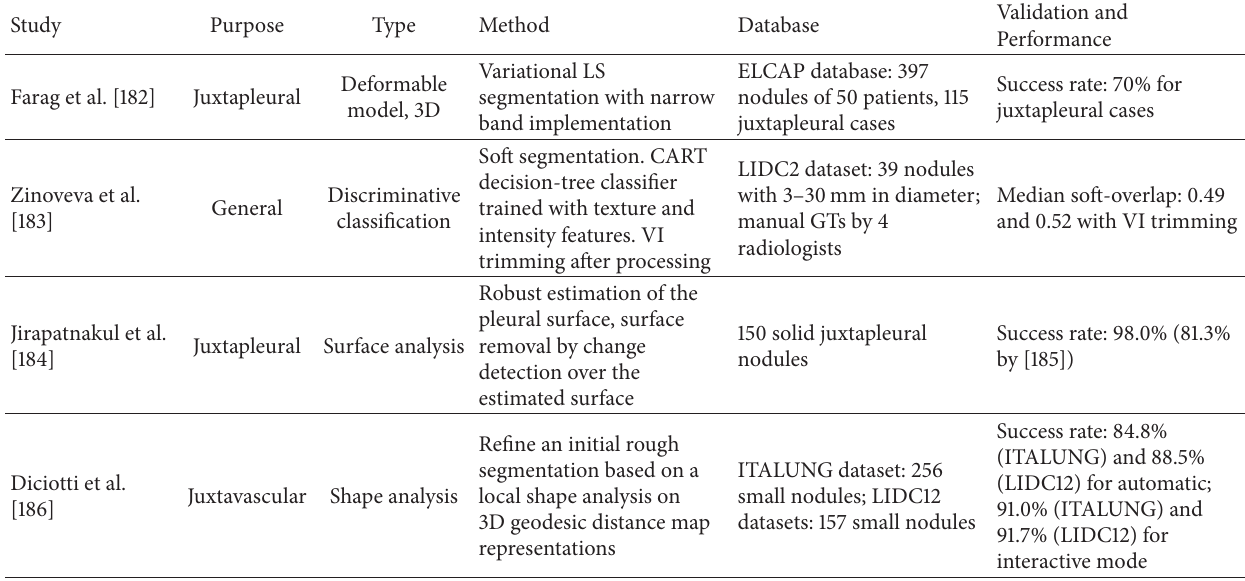
Table 5: Studies on volumetric nodule segmentation reported from 2011 to present. See Table 3 for description of captions.